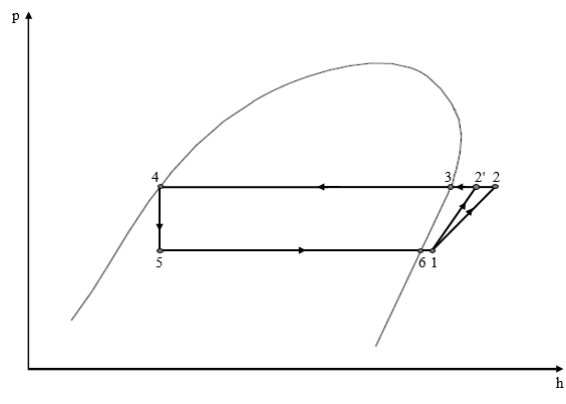
Fig. 2. Single-stage compressor operation in P-h